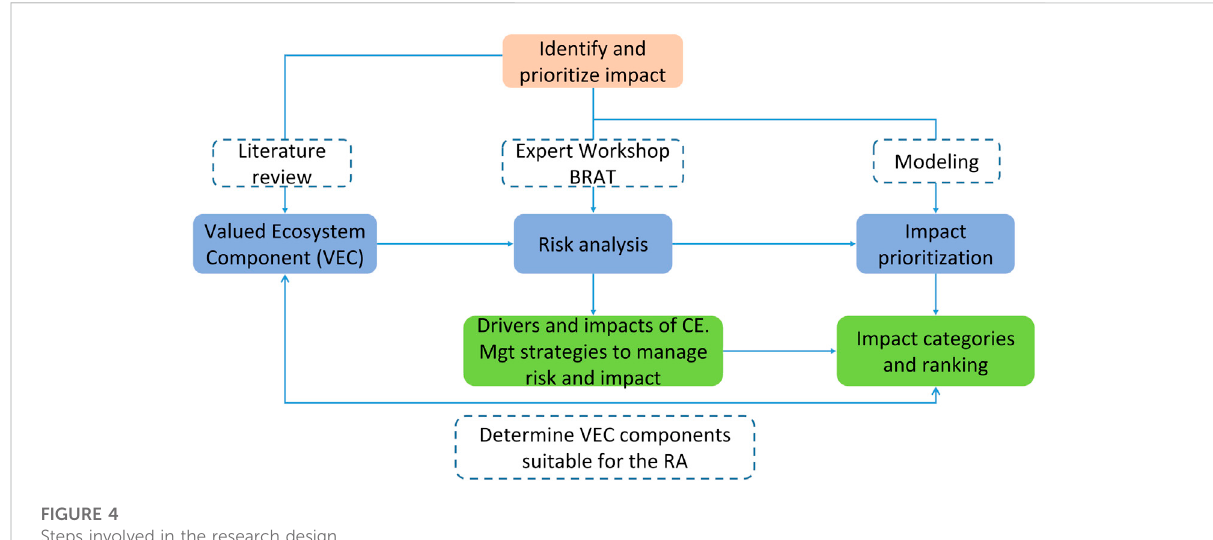
FIGURE 4 Steps involved in the research